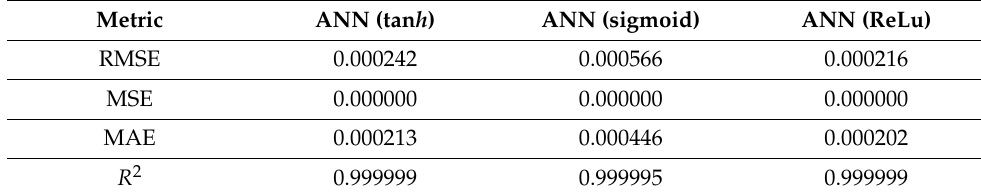
Table 4. Metric of ANN model with different activation functions for target